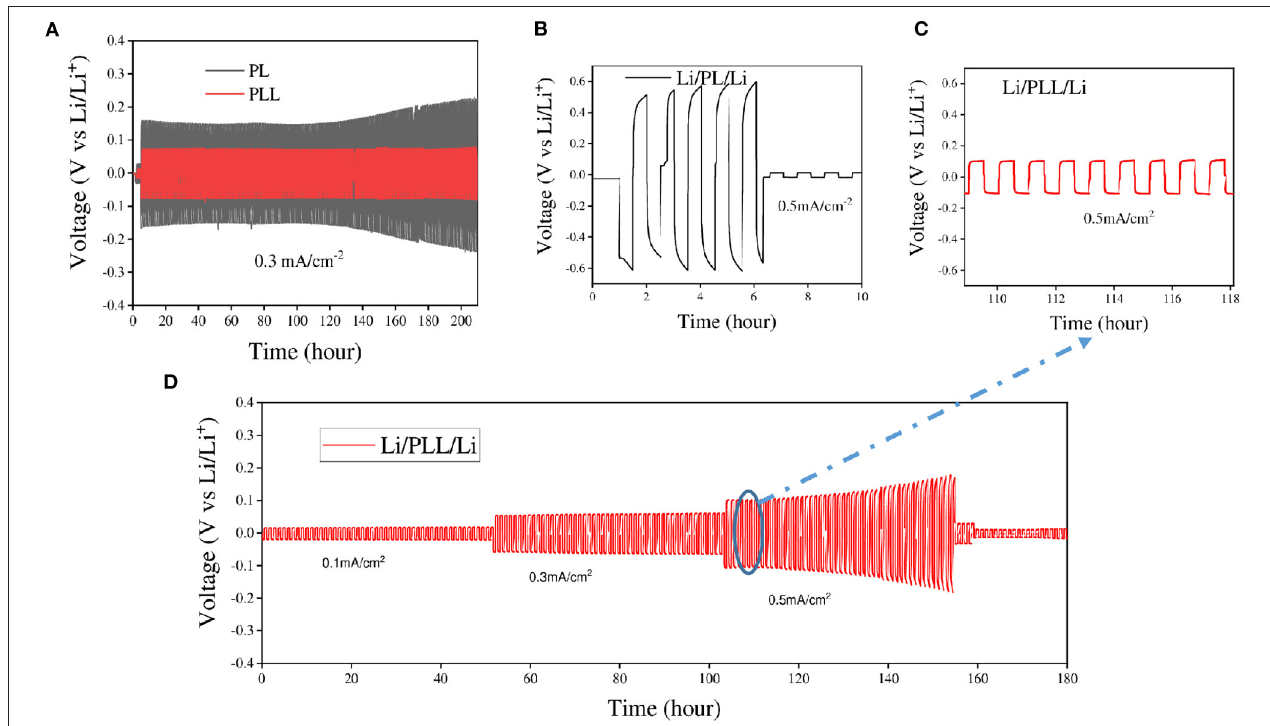
FIGURE 4 | Comparison of Li/PL/Li with Li/PLL/Li in lithium stripping/plating tests at various current densities (A) at 0.3mA cm − 2 and 60 ◦ C, and (B,C) at 0.5mA cm − 2 and 60 ◦ C. (D) Lithium stripping/plating profiles of the PLL electrolyte at various current